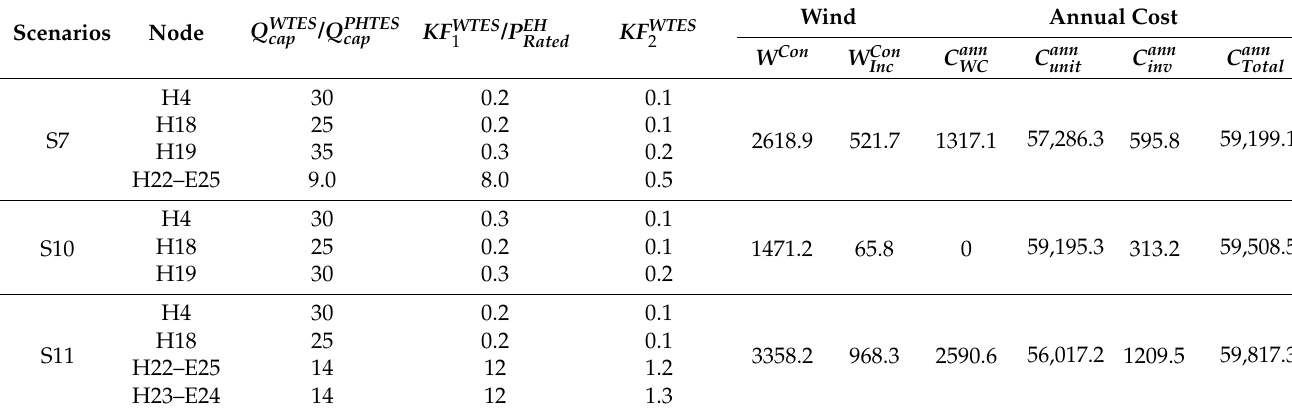
Table 8. Optimization results of configuration schemes of S7 and S10–S11.